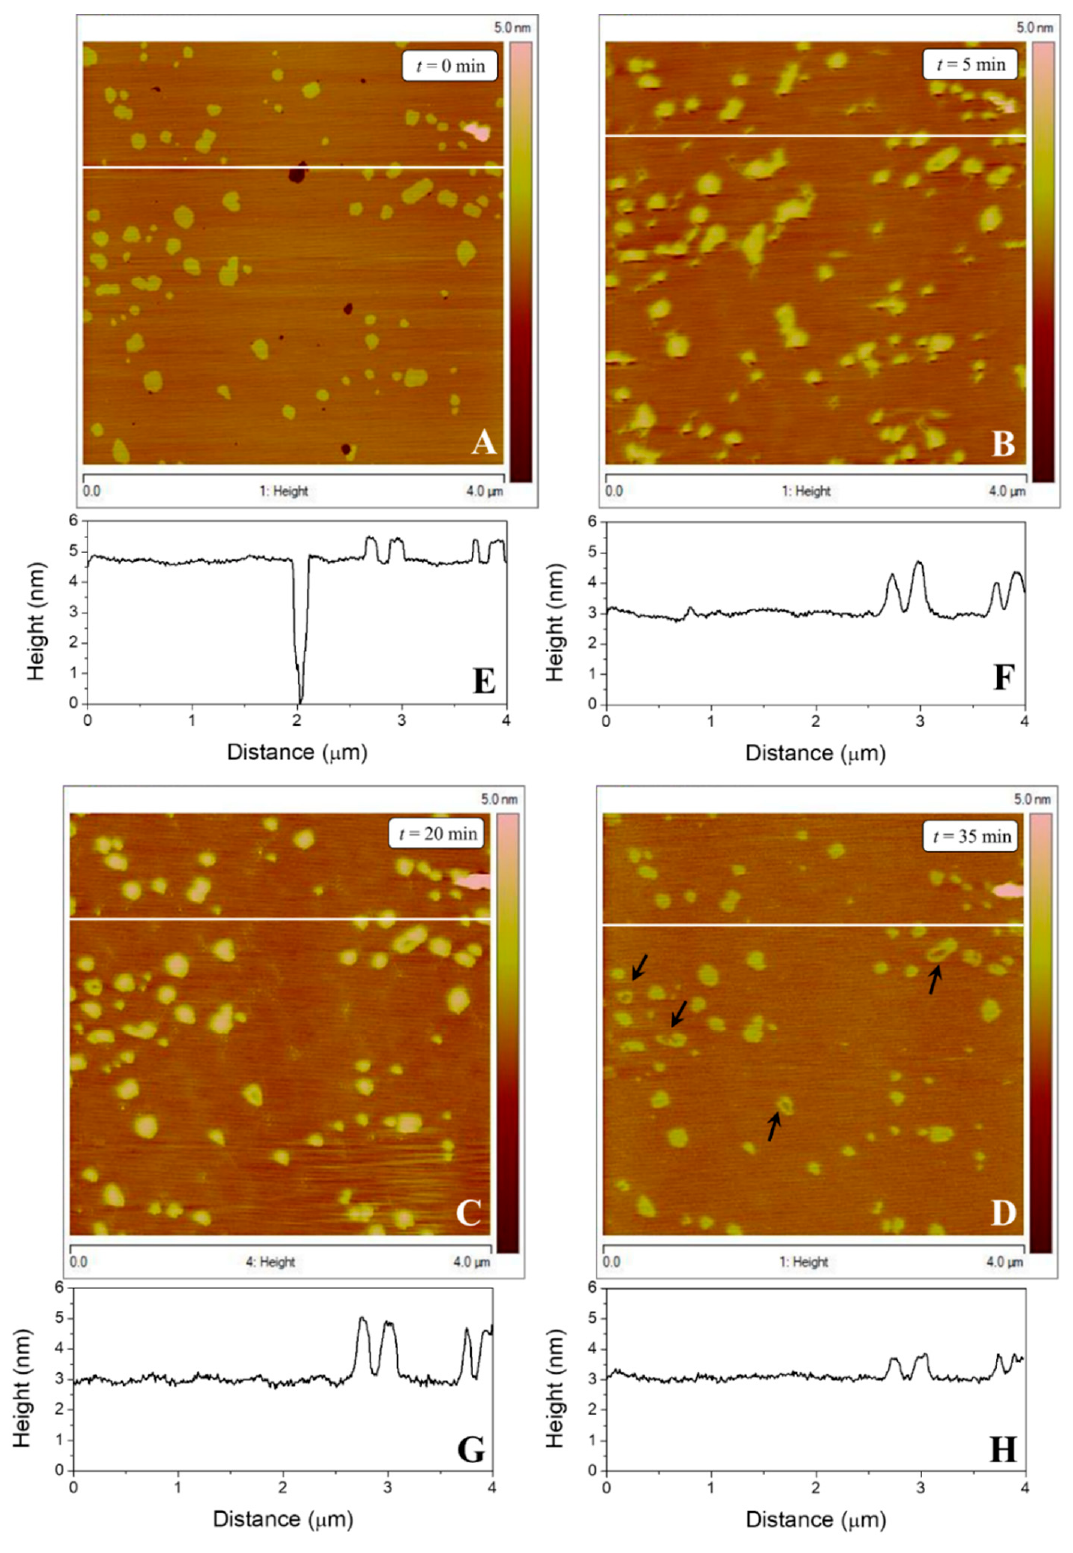
Figure 5. AFM topographic images of a SLB of POPE:POPG (3:1, mol/mol) incubated with 5 nM G1OLO-L 2 OL 2 for different incubation times ( A – D ). Subfigures show one line topography profile for each image ( E – H ) represent the sample height along the white line in the corresponding AFM topographic image. Black arrows in ( D ) point to the degradation of the lipid domain.